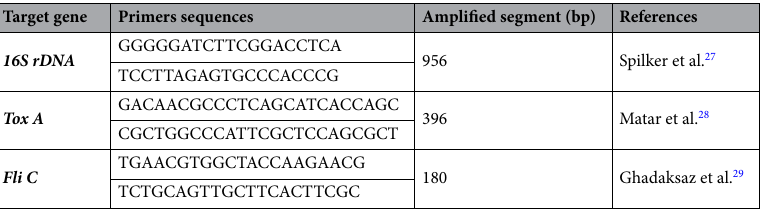
Table 1. Oligonucleotide and primer sequences specific for P. aeruginosa investigated during the